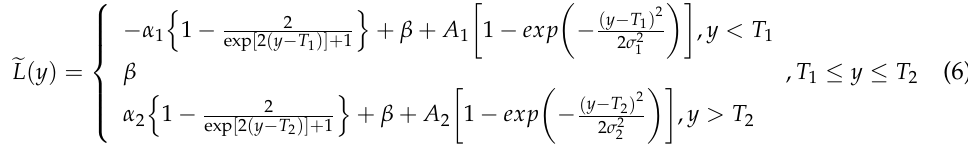
Grey quality gain-loss function of asymmetric-hyperbolic tangent compensation curve is shown in Figure 3. curve is shown in Figure 3.